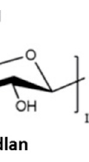
Figure 13. The structure of curdlan.